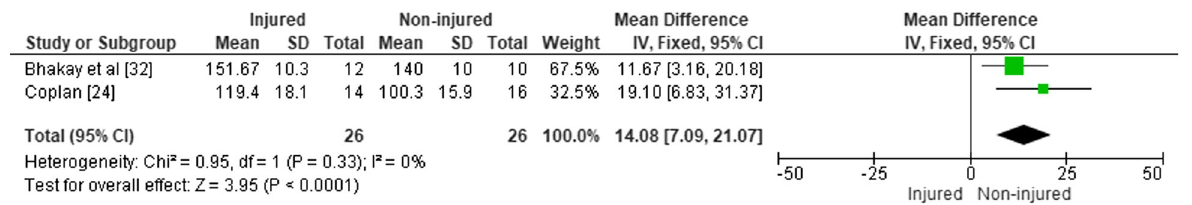
Fig. 4 Forest plot of the comparison of functional turnout between injured and non-injured